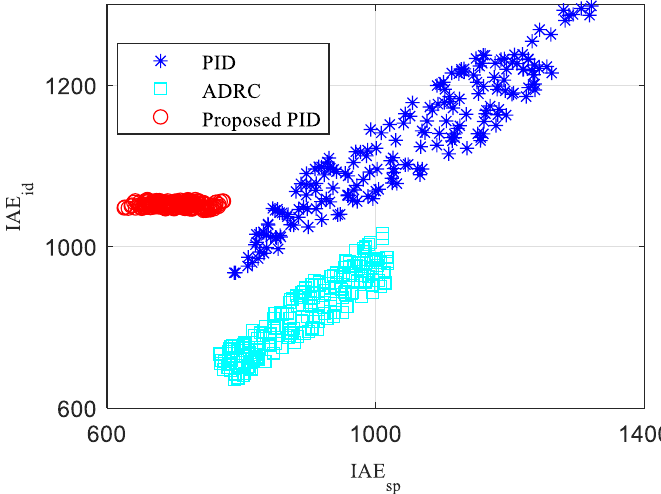
Figure 16. IAE sp and IAE id distribution under an operating condition of 50% load.